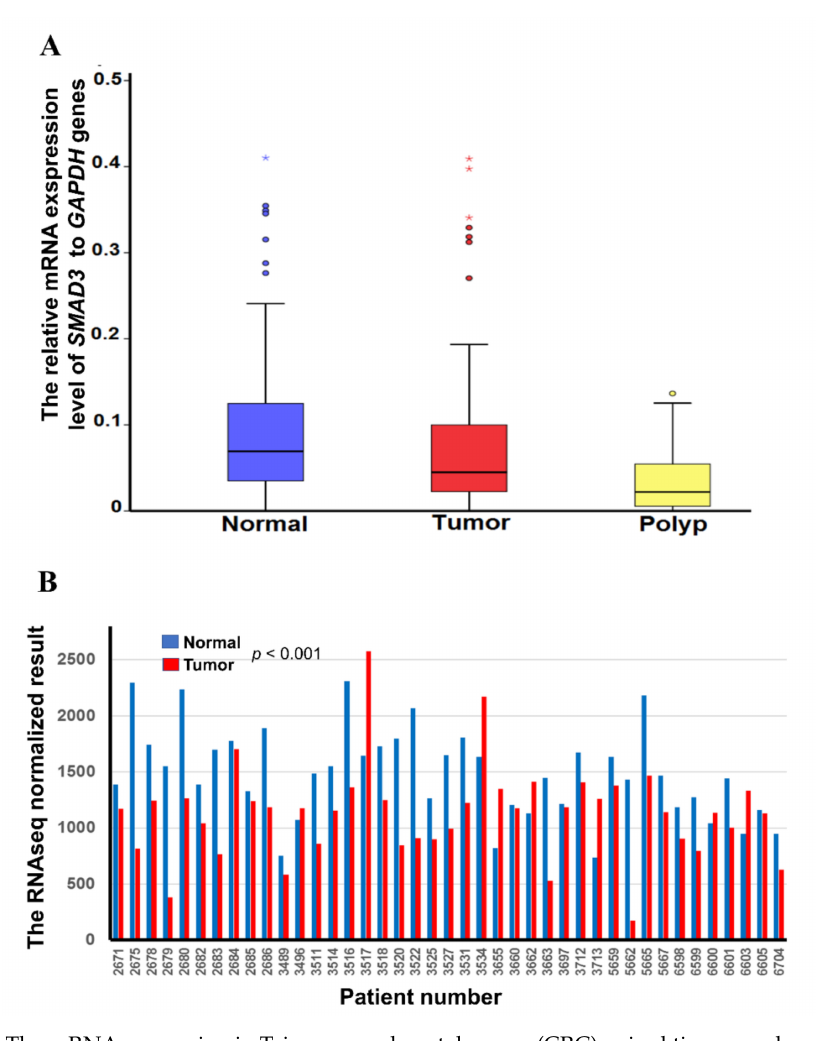
Figure 5. The mRNA expression in Taiwanese colorectal cancer (CRC) paired tissues, polyps, and The Cancer Genome Atlas (TCGA) dataset. ( A ) Boxplot of the SMAD3 mRNA expression level determined by quantitative reverse transcription–polymerase chain reaction in 119 paired colon tissues and nine polyps from the Taiwanese population. ( B ) RNA sequencing data of SMAD3 in 41 matched CRC tumors from the TCGA dataset. Results are shown as mean ± standard